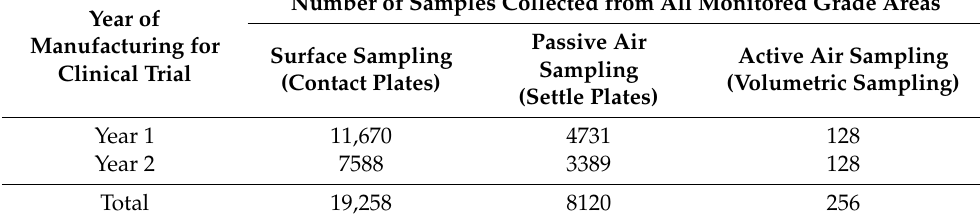
Table 3. The number of samples taken from cleanroom environments with different sampling methods during a two-year clinical trial. Number of Samples Collected from All Monitored Grade Areas Year of Manufacturing for Surface Sampling Clinical Trial (Contact Plates) (Settle